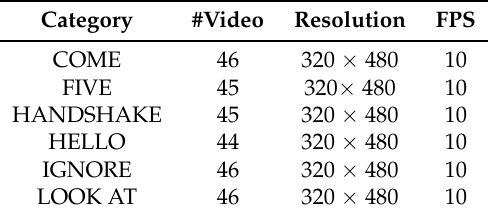
Table 1. Characteristics of each action category.